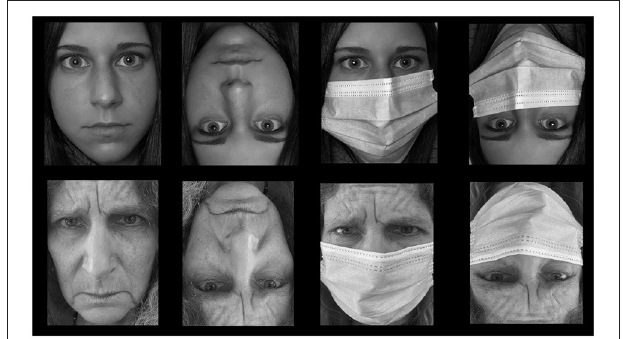
FIGURE 1 | Examples of face images used in the four experiments. The top row presents an example for a young female with neutral emotion. The bottom row gives and example for an old female with angry emotional